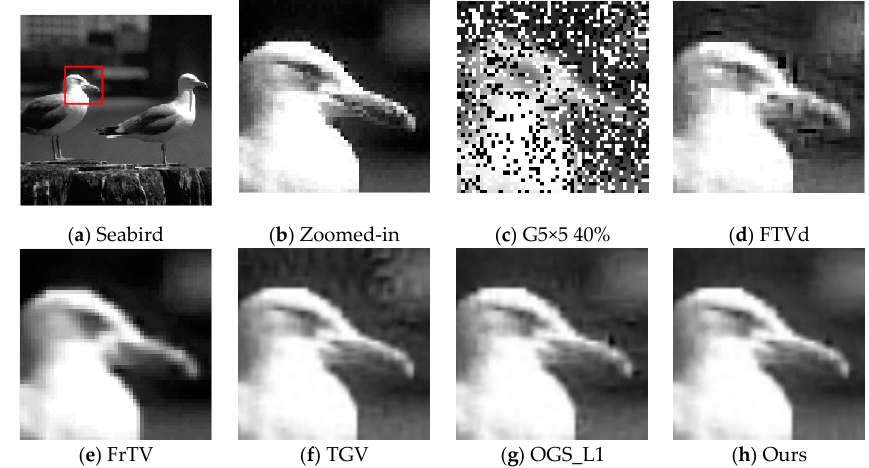
Figure 8. Comparison of the zoomed-in views of reconstructed images by several advanced models and proposed model: ( a ) selected area, ( b ) zoomed-in part of selected area, ( c ) blurred and noisy zoomed-in part owing to convolution with a G 5 × 5, σ = 5 blur kernel at a impulse noise level of 40%, and ( d – h ) zoomed-in parts of reconstructed images by FTVd, FrTV, TGV, OGS_L1, and proposed model, respectively.